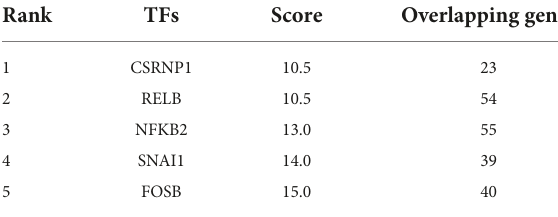
TABLE 4 The top 5 potential transcription factors of